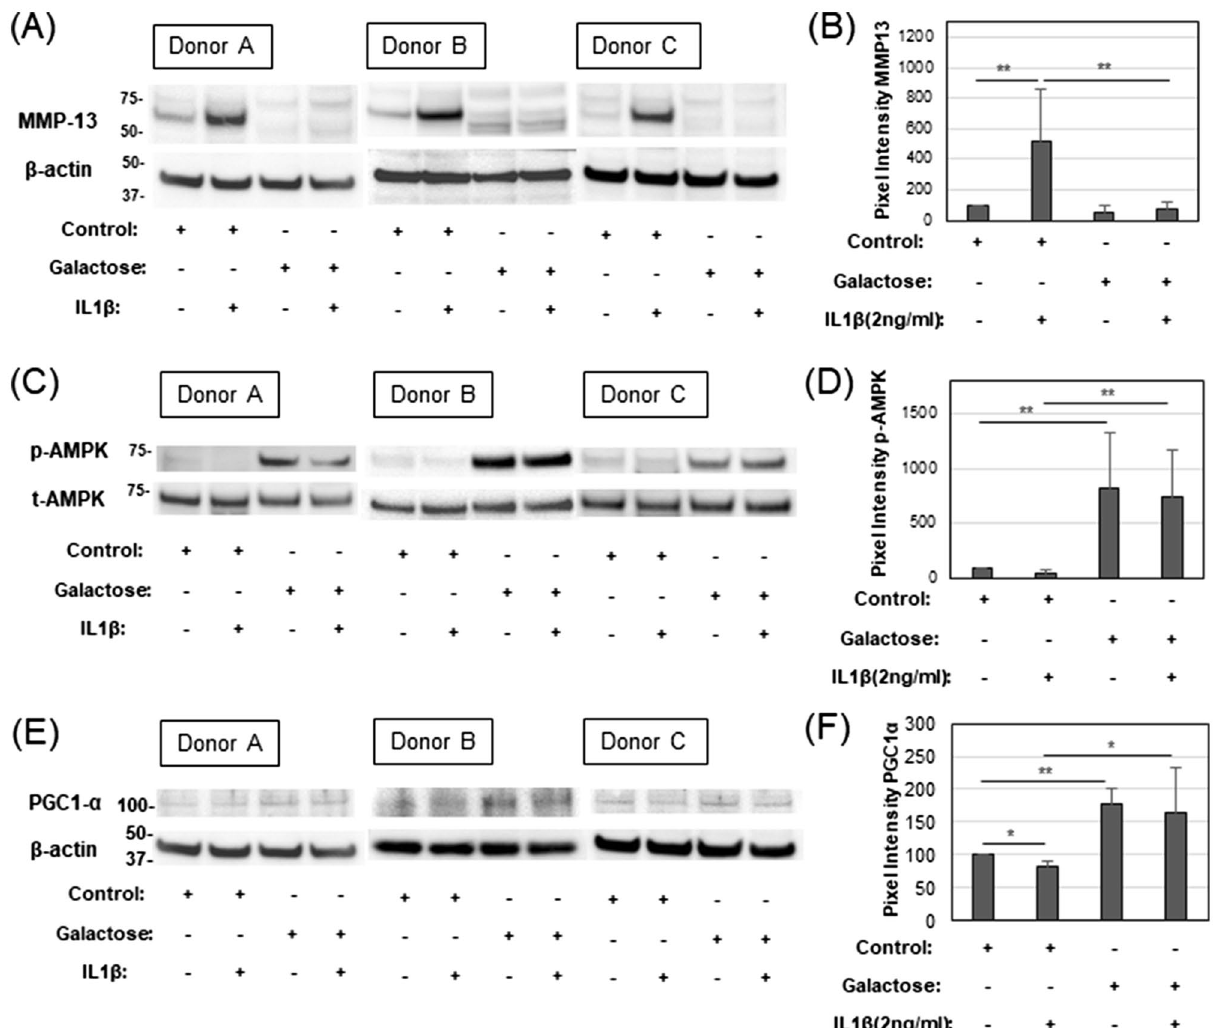
Figure 7. Effects of IL1β and galactose on human OA chondrocytes. Donor A is a 77 year old woman, Donor B is a 73 year old woman, Donor C is a 77 year old woman. ( A ) Representative western blots of the expression of MMP13 protein of Human chondrocytes (three different donors) treated with or without IL1β in Control glucose or galactose culture medium. ( B ) Summary of change in pixel intensity for MMP13 bands with control untreated set = 100 [mean ± S.D. (error bars), n = 3]. ( C ) Representative western blots of phospho-AMPK (p-AMPK) and total-AMPK (t-AMPK). ( D ) Summary of change in pixel intensity of bands for p-AMPKα (normalized to pixel intensity of its respective t-AMPK band) with the control, untreated chondrocytes in glucose culture medium set to 100. ( E ) Representative western blots of PGC1α and β-actin. ( F ) Summary of change in pixel intensity of bands for PGC1α (normalized to pixel intensity of its respective β-actin band) wherein the intensity of the p-AMPK band of control, untreated chondrocytes in glucose culture medium were set to 100. ANOVA followed by Tukey post-hoc test was used for statistical analysis. *p < 0.05; **p < 0.01. The entire full-length blots are shown in Supplementary Figs.